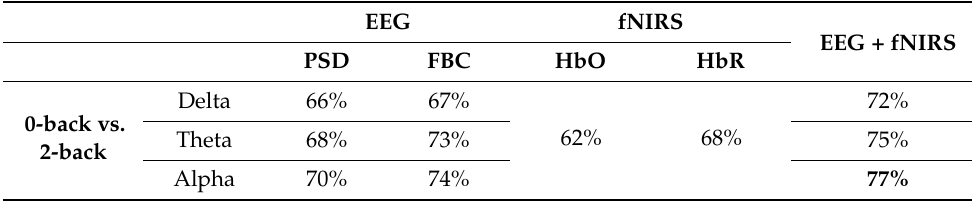
Table 3. SVM classification accuracy of 0-back vs. 3-back using different features.